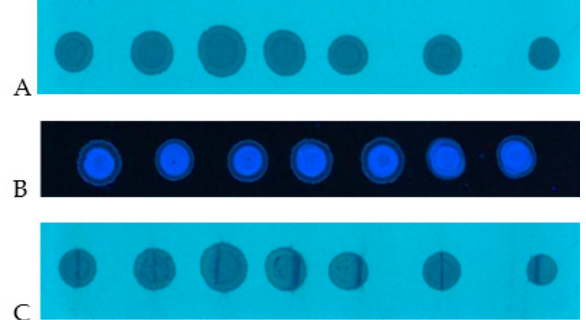
Figure 3. Mixture (serum sample) starting spots: ( A ) after sample application, λ = 254 nm; ( B ) after sample application, λ = 366 nm; ( C ) after starting spot narrowing, λ = 254 nm. HPTLC Silica gel 60 F254 (Merck), mobile phase: methanol.